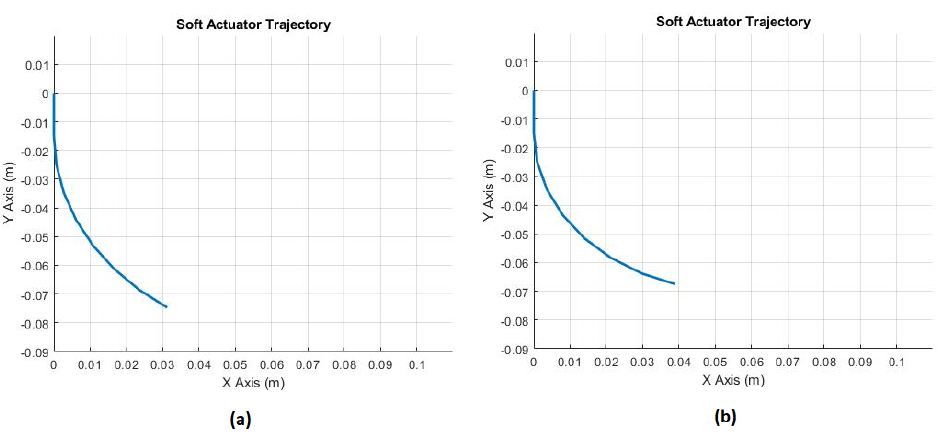
Figure 14. Modeled Displacement of soft actuator flexion at different pressures. ( a ) Calculated Displacement at 1.5 kg/cm 2 . ( b ) Calculated Displacement at 2 kg/cm 2